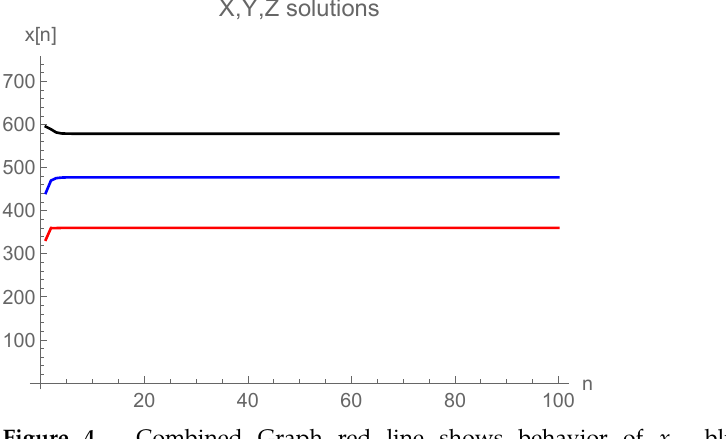
Figure 4. Combined Graph red line shows behavior of x n , blue line shows behavior of y n and black line shows behavior of z n for α = 167, β = 0.01, γ = 0.03, δ = 0.4, ζ = 155, η = 0.05, µ = 0.05, ε = 0.3, υ = 144, ρ = 0.03, σ = 0.08, ω = 0.2. with initial conditions x 0 = 10.0, y 0 = 20.0 and z 0 =